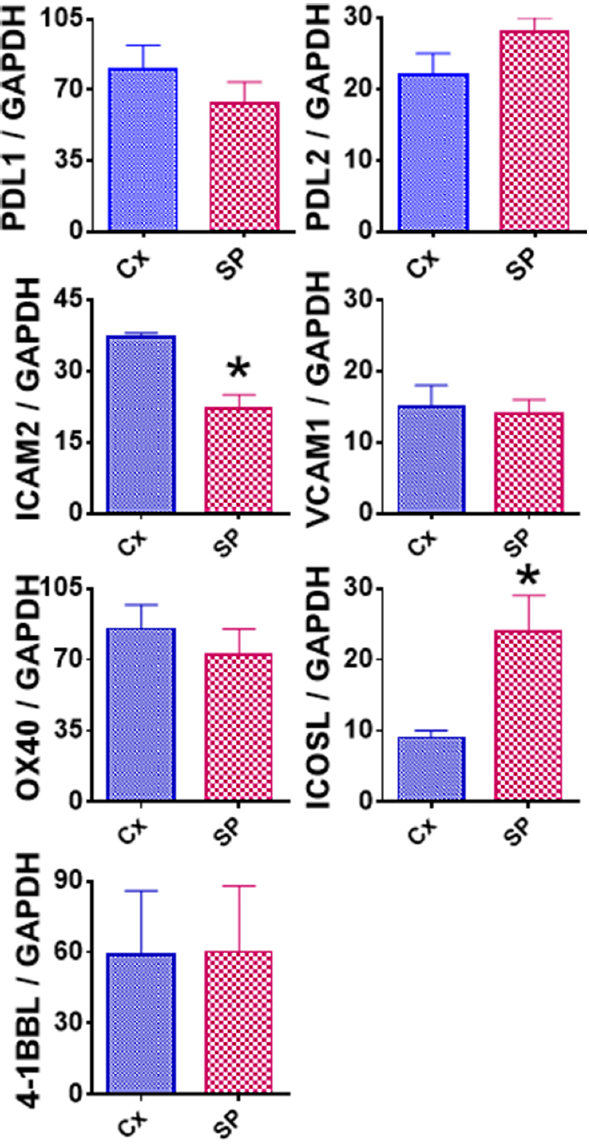
Fig. 2. The effect of SARS-CoV-2 SP on the expression of key costimulatory, coinhibitory, and cell adhesion molecules in LNCaP cells evaluated by RT-PCR. The costimulatory, coin- hibitory, and cell adhesion molecules studied include PDL1, PDL2, ICAM-2, VCAM-1, OX40, ICOSL, 4-1BBL. The inter- nal control, GAPDH, was used to compare levels of expression. The experiments were conducted in triplicate with the results depicted on graphs as a mean ratio of molecule densitometric Units/GAPDH + SEM ( × 100). Statistically significant results are indicated by asterisk (*) ( p <